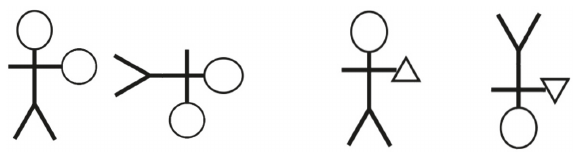
Figure 1: Examples of same (left) and different (right) trials for the rotated figures